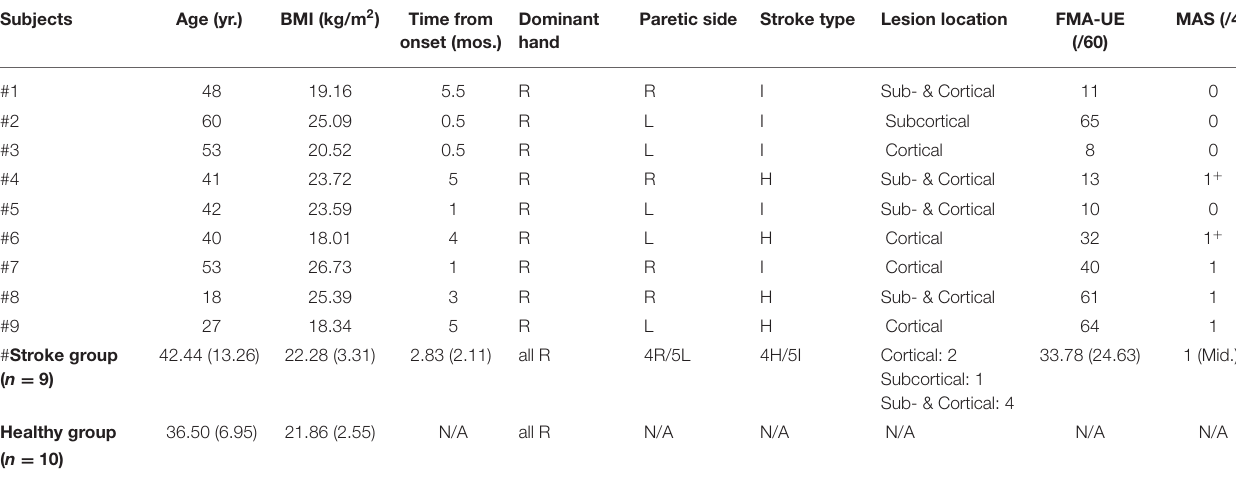
TABLE 1 | Demographic characteristics of the participants.